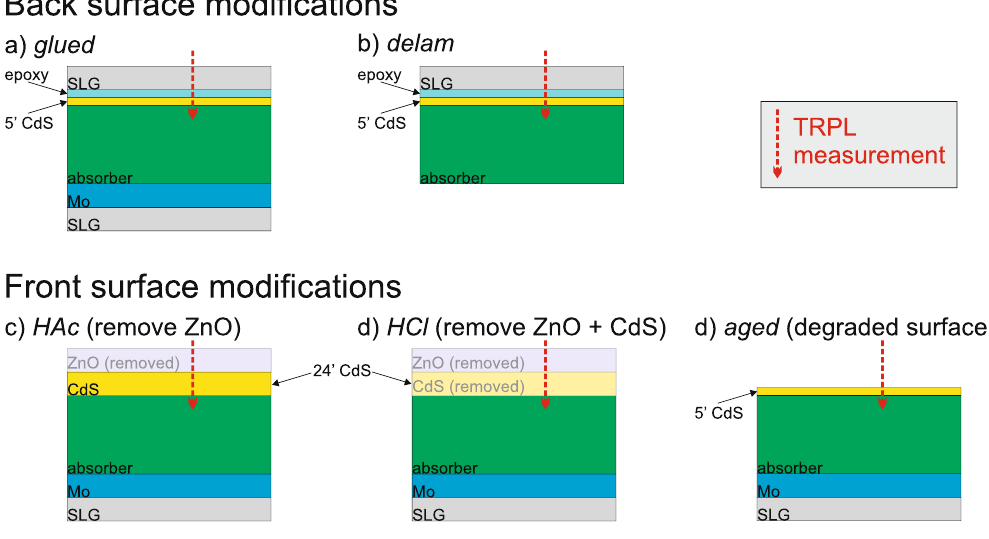
Figure 2. Sample modifications for measuring the same absorber with different surface